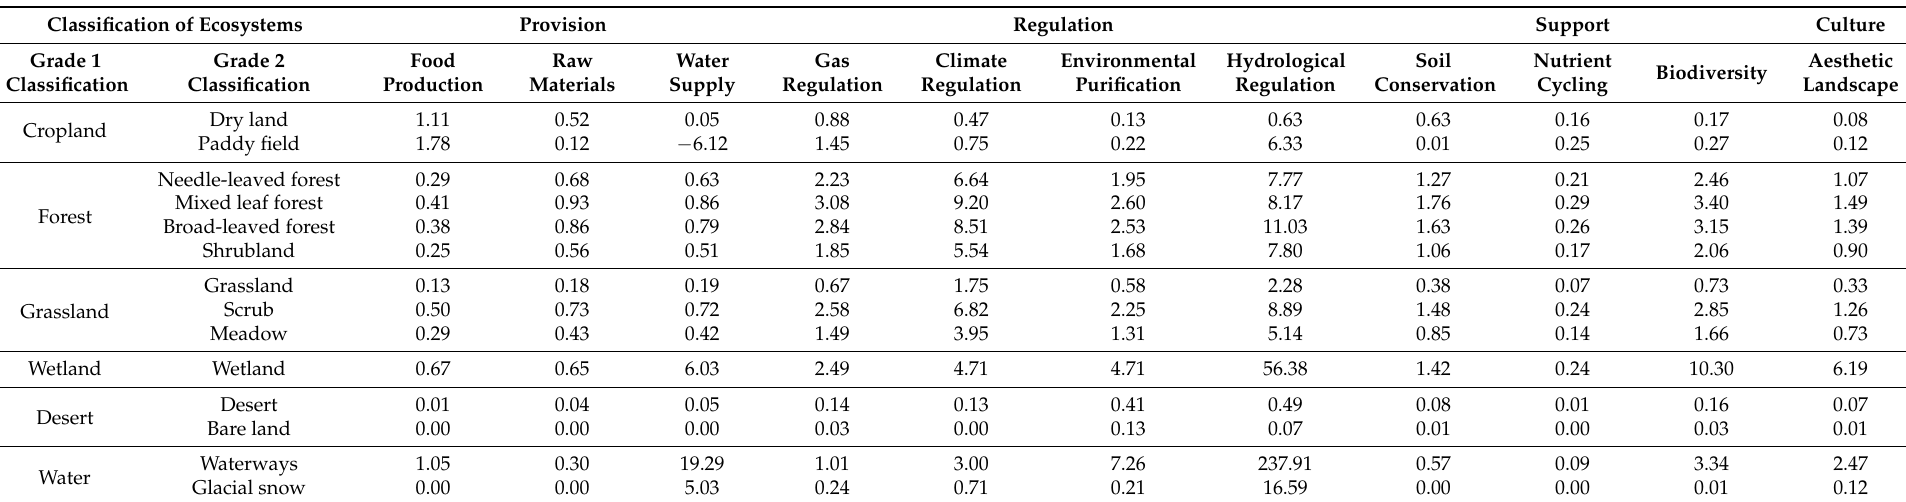
Table 3. Modified equivalent factors for ESV per unit area in Nanjing.